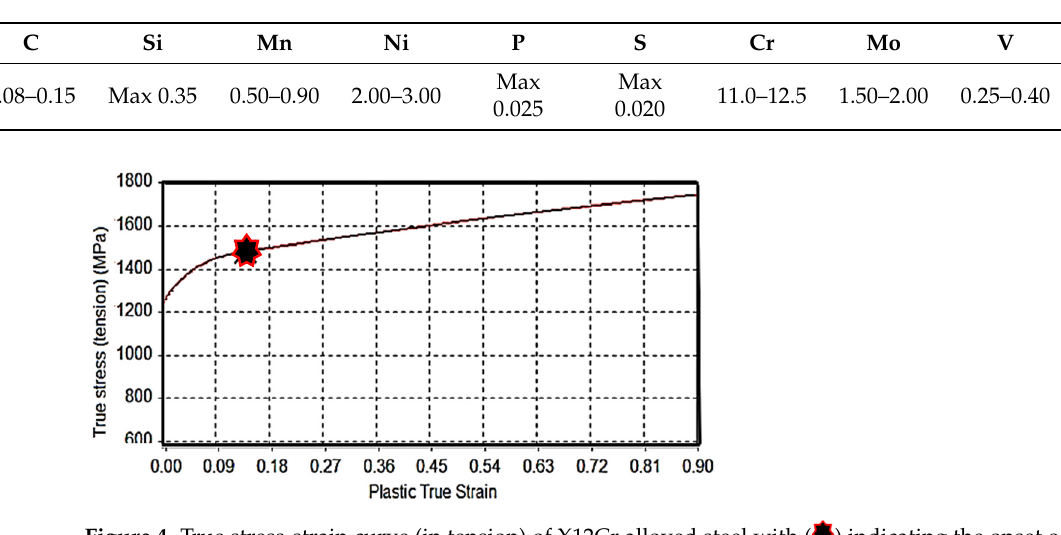
Table 3. Chemical properties of X12Cr steel material [31].